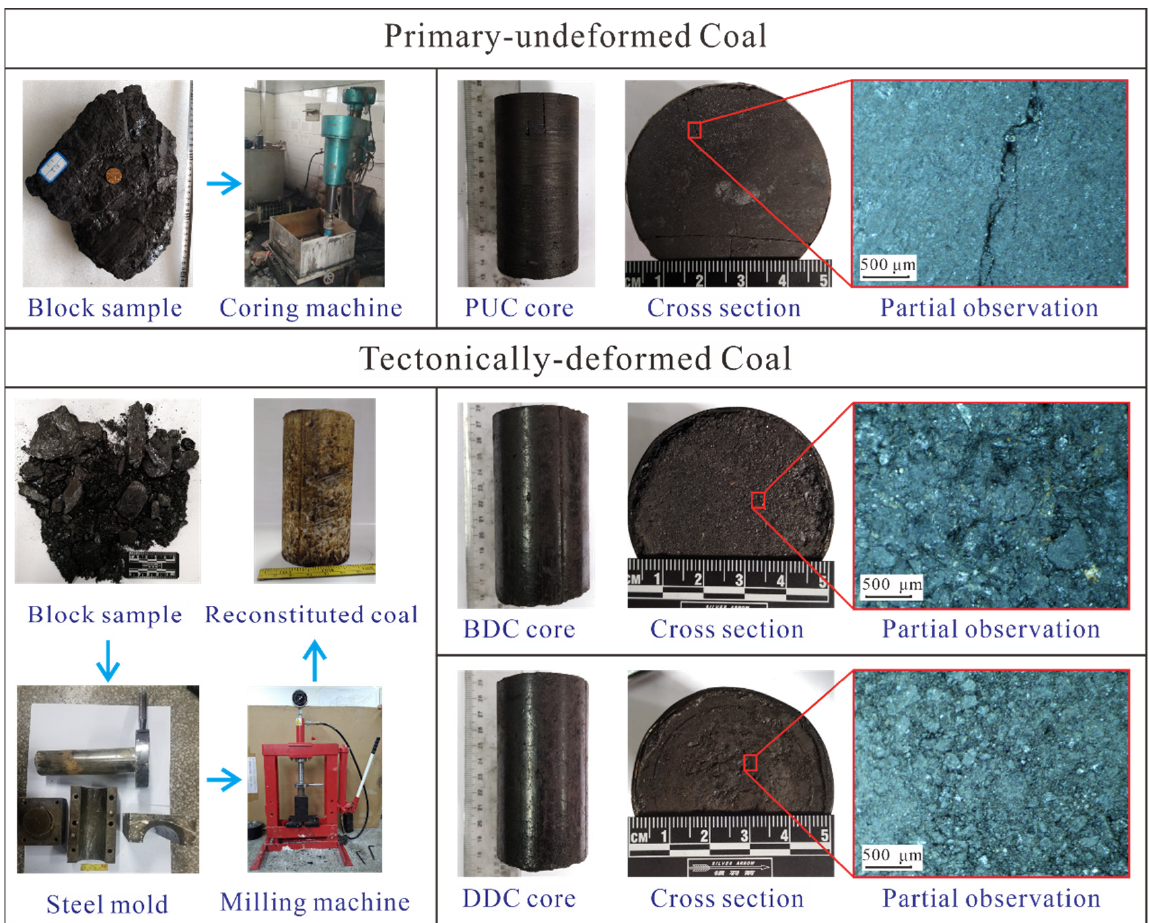
Figure 2. Sample preparation method and coal cores.